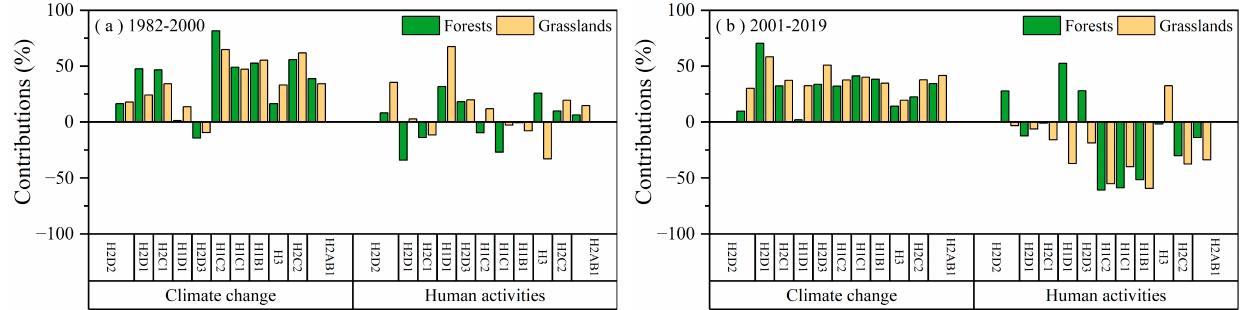
Figure 11. Average contribution rate of climate change and human activities to forests and grasslands in different climate zones of the QTP.